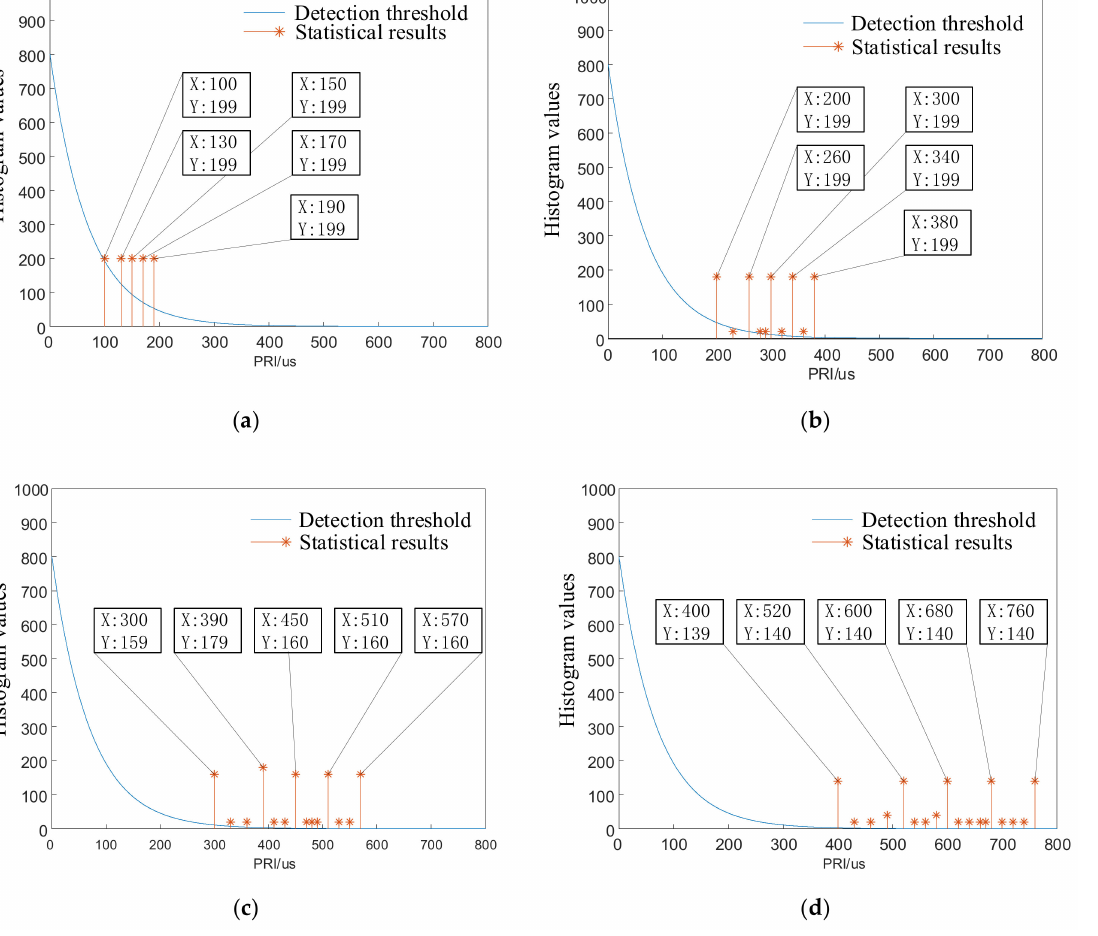
Figure 7. SDIF algorithm for the D&S signal first-to-fourth-order histogram sorting results. ( a ) The histogram of first-order TOA difference in the D&S signal; ( b ) the histogram of second-order TOA difference in the D&S signal; ( c ) the histogram of the third-order TOA difference in the D&S signal; ( d ) the histogram of the fourth-order TOA difference in the D&S